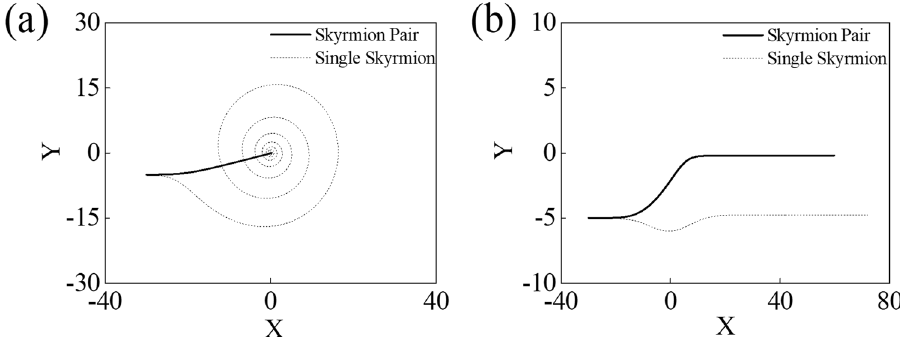
Figure 4. Trajectories of a single skyrmion and a skyrmion pair influenced by an attractive pinning potential U ( x , y ) = − U 0 exp[ − ( x 2 + y 2 )/100] were obtained by numerical calculations. Trajectories under ( a ) strong pinning potential( U 0 = 50) and ( b ) weak potential ( U 0 = 0.2) are represented with lines. Solid lines denote trajectories of a skyrmion pair and dashed lines denote those of a single skyrmion. The initial position is set at r 0 = ( − 30, − 5).